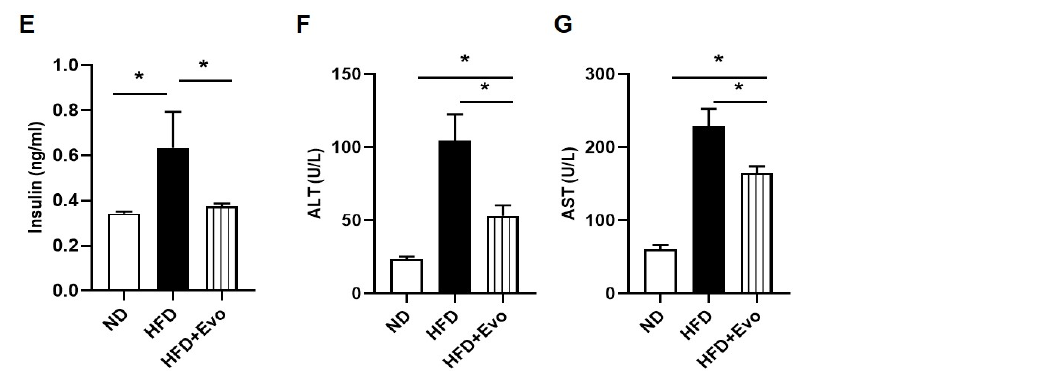
Figure 1. Effect of evogliptin on body and fat weights in mice with HFD: mice were euthanized 16 weeks after HFD feeding. ( A ) Body weight, ( B ) epididymal fat weight, ( C ) glucose level, ( D ) food intake, and serum ( E ) insulin, ( F ) ALT, and ( G ) AST levels at 16 weeks after HFD feeding. Values are mean ± SEM. * p < 0.05, HFD: high-fat diet; ND: normal diet. ALT: Alanine aminotransferase; AST: Aspartate aminotransferase.